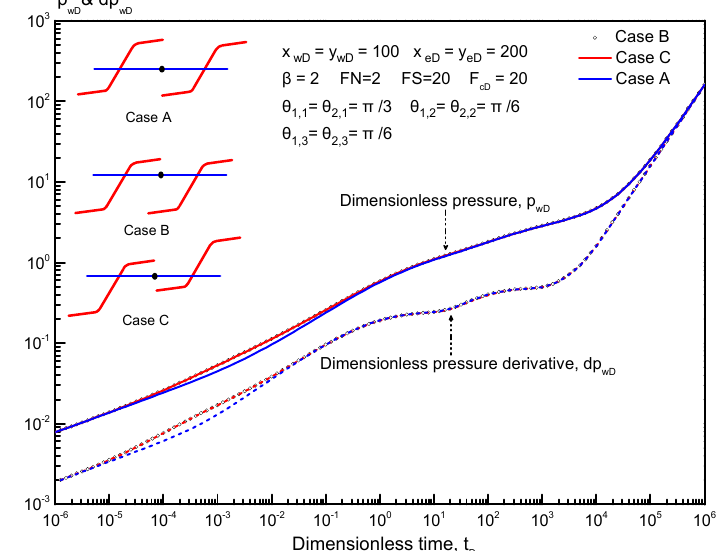
Figure 18. Effect of complex fracture pattern under large dimensionless fracture spacing on pressure and the pressure derivative (FS = 20).